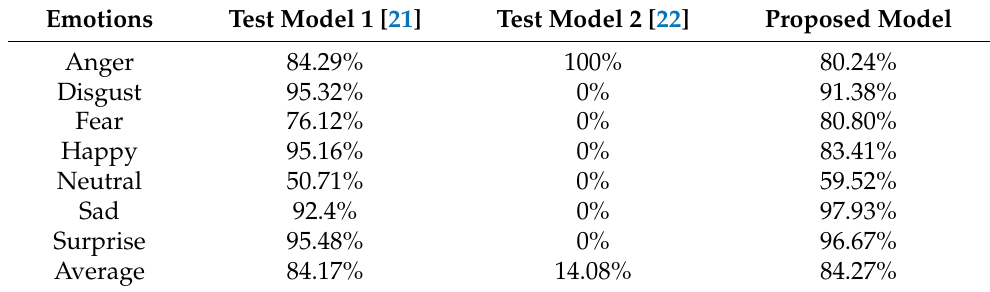
Table 22. Comparison of Test Model 1, Test Model 2, and proposed model after 10 epochs with the cross dataset.